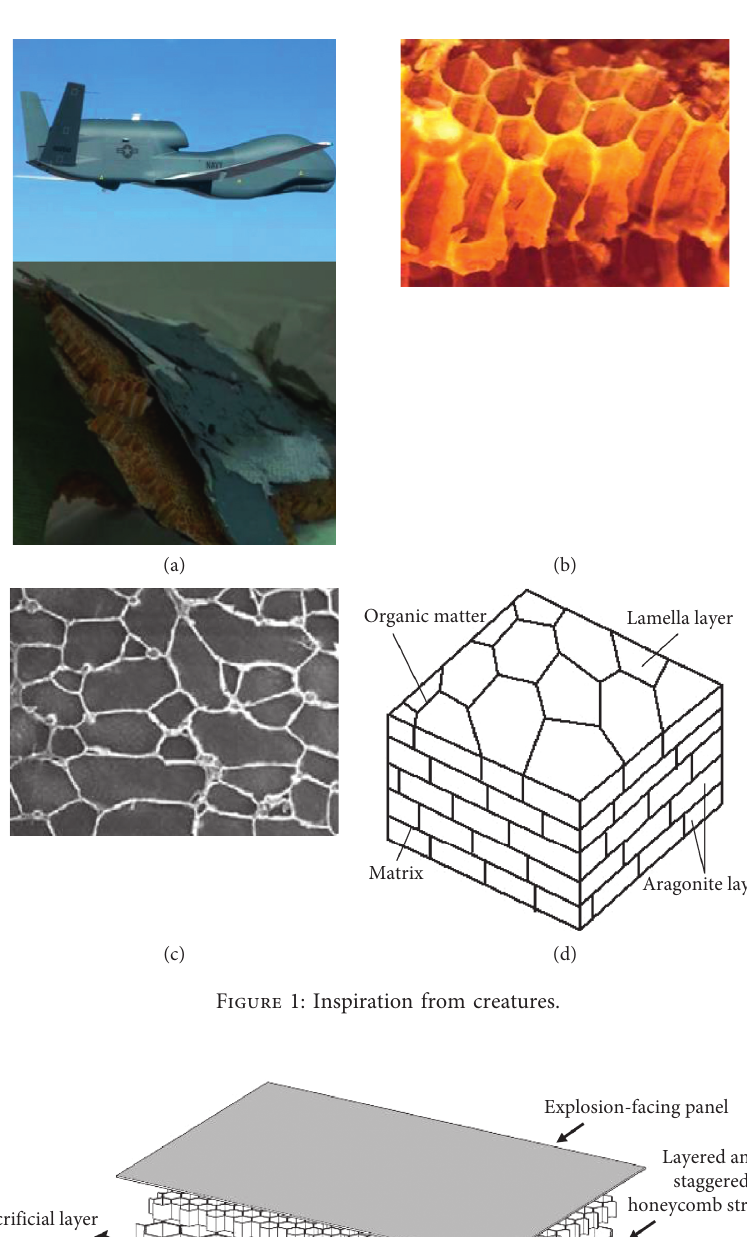
Figure 1: Inspiration from